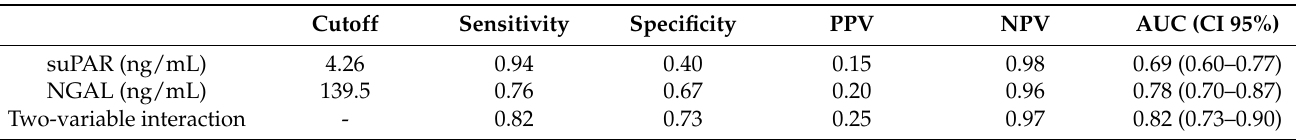
Table 2. Diagnostic accuracy of suPAR, NGAL and the combination of both biomarkers, using optimal cut-off values, for predicting AKI.